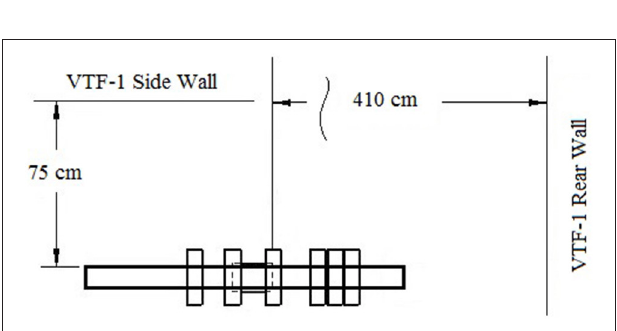
FIGURE 2 | MadHeX replica orientation inside VTF-1 and distances between exit plane and facility walls.